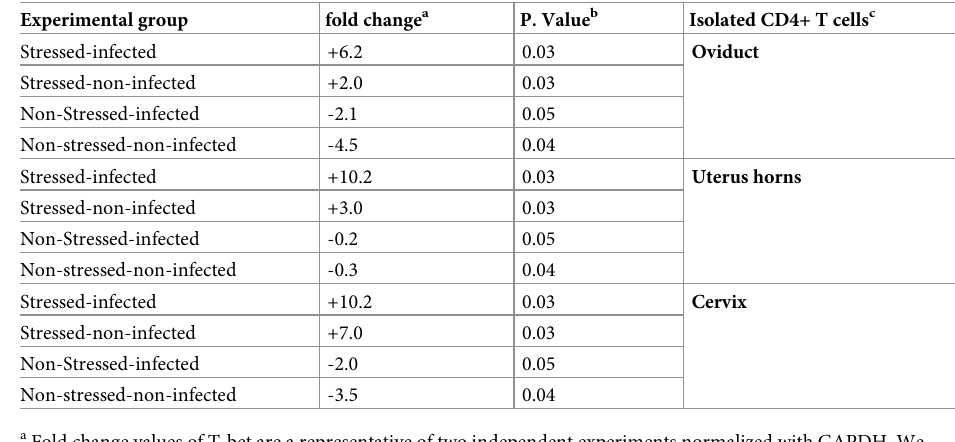
GATA3, T-bet, IL-4, and IFN- γ in splenic na ï ve CD4+ T cells isolated from stressed and non- stressed mice with or without C . muridarum genital infection. As shown in Fig 4A and 4C , the normalized mRNA levels of GATA-3 and IL-4 in CD+4 T cells displayed significantly increased expression in stressed and infected mice. In contrast, T-bet and IFN- γ in CD+4 T cells displayed decreased expression considerably in stressed and infected mice ( Fig 4B and 4D ). Our results show a direct correlation between the Ct values and fold-changes of the Table 2. Fold-changes of gene expression of T-bet in lysates of the whole or parts of the genital tract of stressed or non-stressed mice during C . muridarum genital infection. T-bet expression in the oviduct and uterus horns is shown, but gene expression of T-bet in the cervix of stressed or non-stressed mice was undetectable. Experimental group fold change a P. Value b Isolated CD4+ T cells c Stressed-infected +1.0 0.04 Stressed-non-infected +1.0 0.03 Oviduct Non-Stressed-infected +8.5 0.03 Non-stressed-non-infected +6.0 0.03 Stressed-infected +3.2 0.05 Stressed-non-infected +1.0 0.03 Uterus horns Non-Stressed-infected +7.2 0.04 Non-stressed-non-infected +4.7